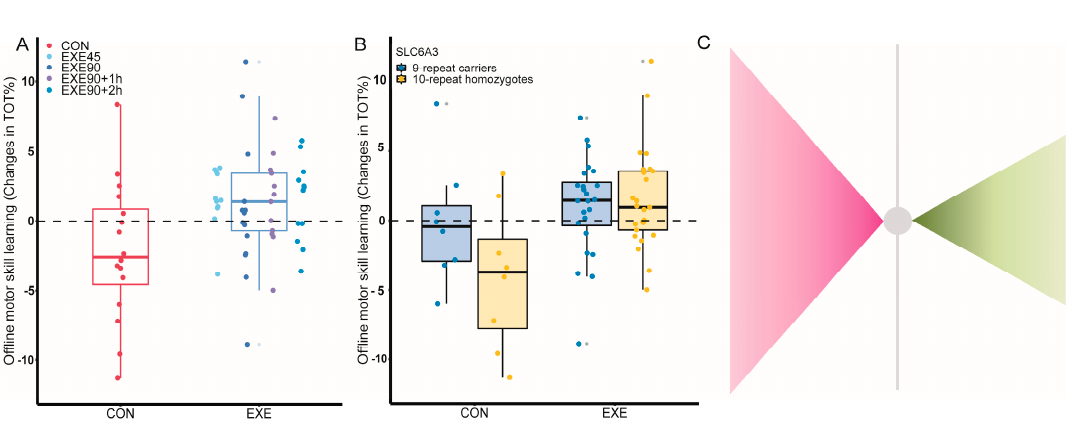
Figure 2. The effect of exercise and gene variance on consolidation. ( A ) The effect of exercise on motor skill consolidation with rest condition (red) on the left and the four different exercise protocols depicted in different shades of blue. Note that data analysis is conducted with the four groups collapsed to one. The boxes range from the first to the third quartile with second quartile (median) depicted as the horizontal line. Whiskers represent 1.5 times the interquartile range between the first and third quartile. The scatter plots represent individual data points, and outliers are marked with an adjacent grey dot. ( B ) The effect of the variable number of tandem repeats (VNTR) polymorphism in the SL6A3 gene. Note the ‘recover’ effect of exercise for 10 repeat carriers. ( C ) Papillion-plot illustrating the variance explained by the identified SNPs. Vertical ranges of the triangles depict the variation of off-line changes i.e. the inversed relative proportion of variance in relation to the full model explained by the model with (pink) and without SNPs in the model. Note how the capacity to explain the variance in the effects of exercise on skill retention changes when SNPs are introduced in the model, suggesting an interaction. Values are derived from model estimates.